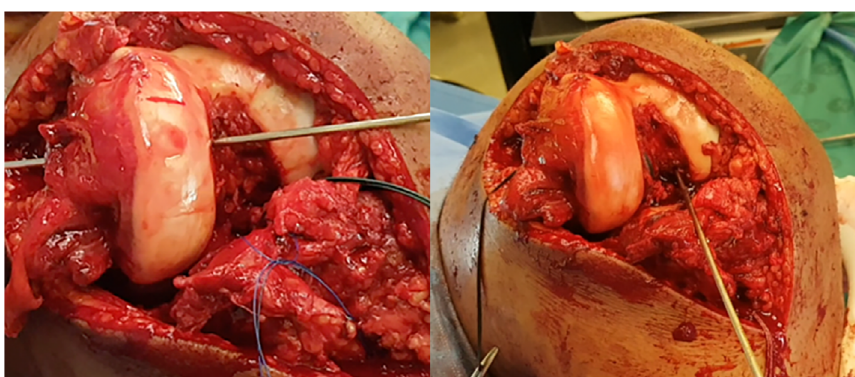
Figure 2. Intraoperative access to the notch of left through a medial parapatellar dissection with the patella retracted. This gives appropriate access to important structures in the notch. Left : guidewire drilled through the femoral footprint of the anterolateral bundle of the posterior cruciate ligament. Right : guidewire drilled through the femoral footprint of the anterior cruciate ligament.